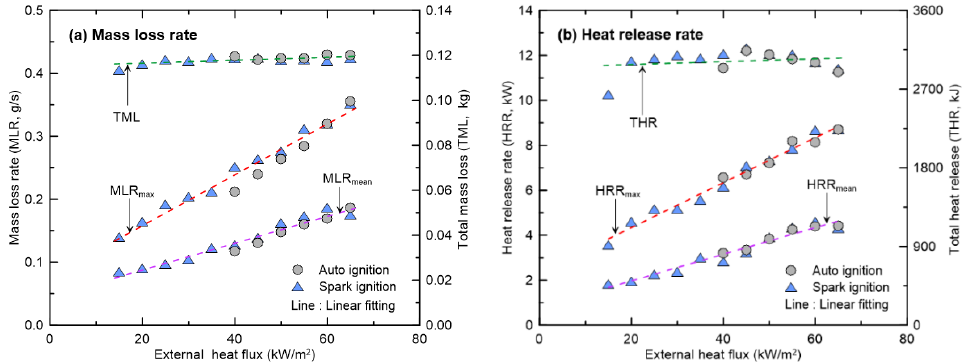
Figure 6. Heat release rates and mass loss rates as a function of external heat flux for auto and spark ignition.